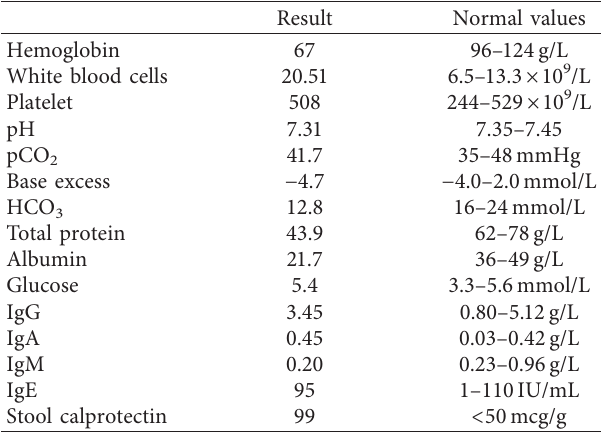
Table 1: Results of initial laboratory